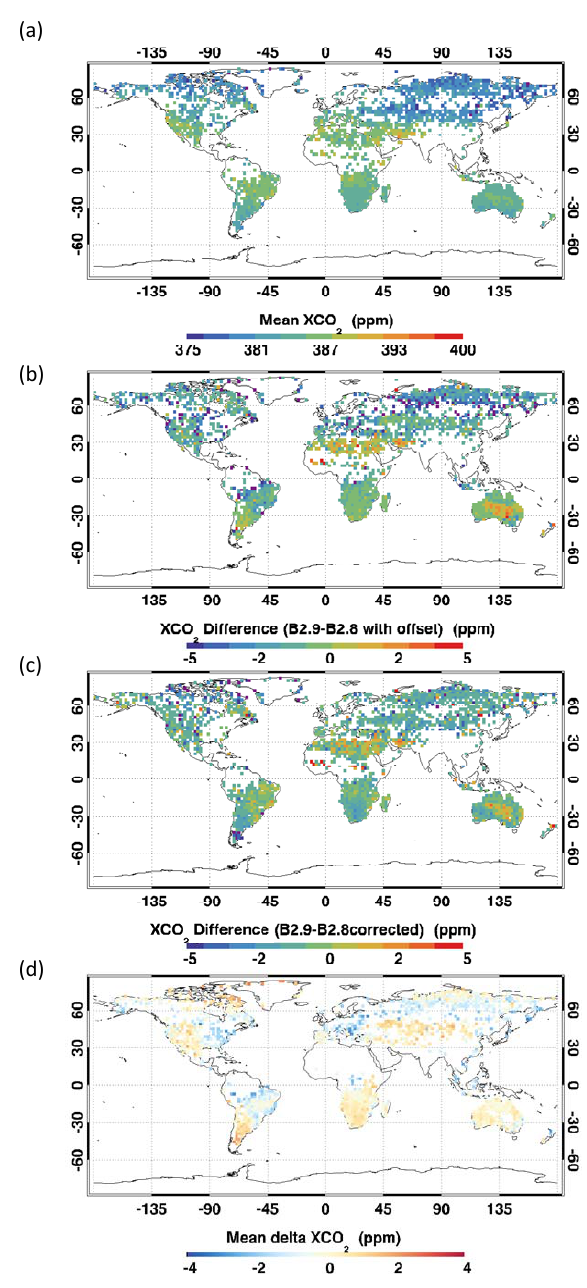
Fig. 17. Comparison of the preliminary B2.9 product with rescaled and corrected versions of the B2.8 product. (a) Map of the B2.9 product for July 2009, using the same post-processing filters used for the B2.8 results. (b) Difference between the B2.9 product and the B2.8 product, offset by ∼ 7ppm to remove the global X CO bias. (c) Difference between the raw B2.9 product and the B2.8 results corrected for bias with the empirical approach developed by Wunch et al. (2011b). (d) Differences between the B2.9 results cor- rected for bias with the empirical approach developed by Wunch et al. (2011) and raw B2.9